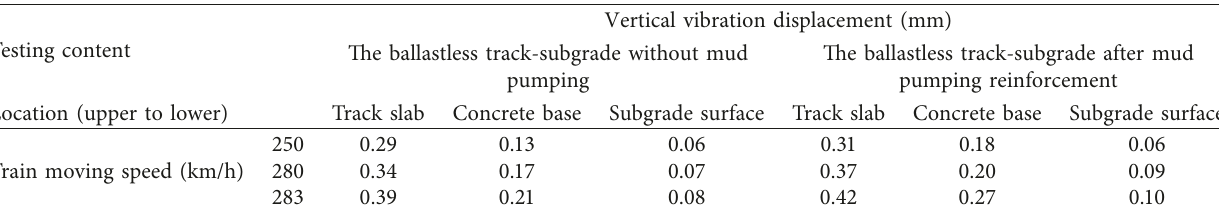
Table 6: The vertical vibration displacement of the ballastless track-subgrade after mud pumping has been reinforced.